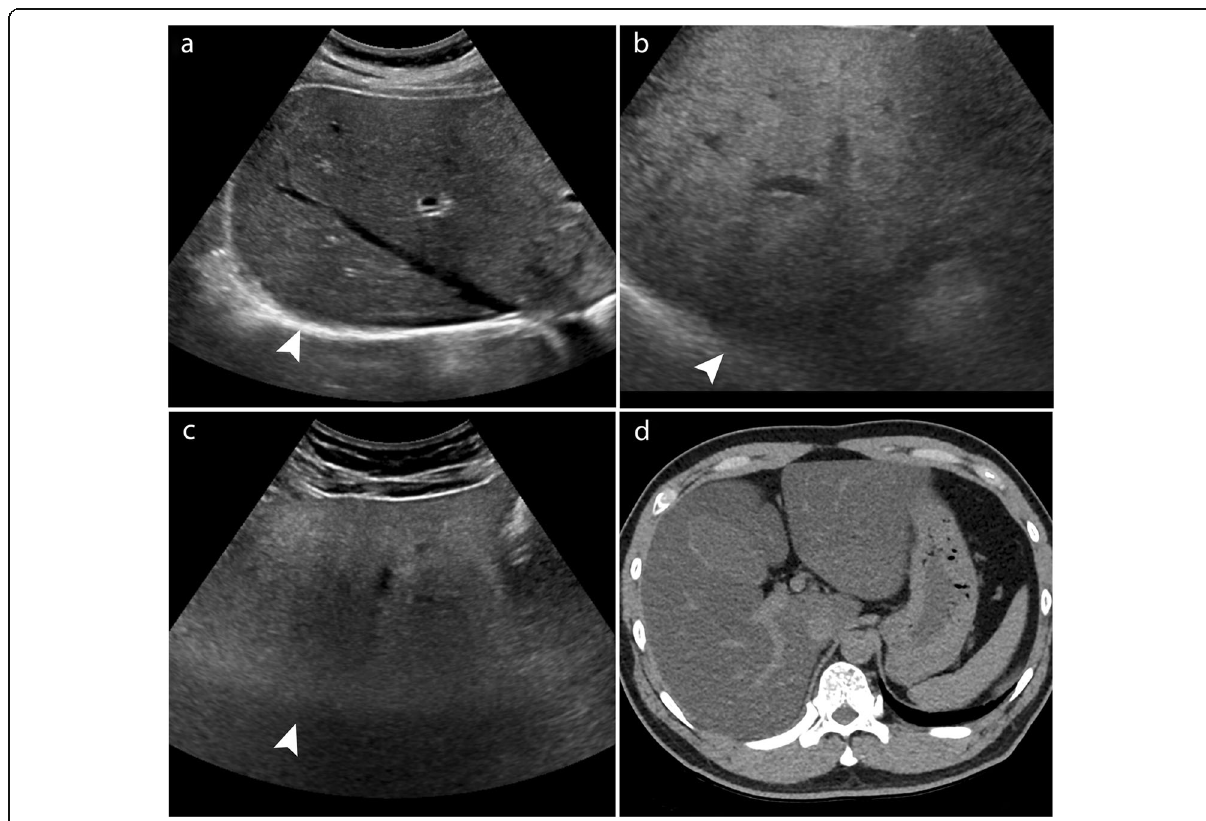
Fig. 1 Liver Imaging Reporting and Data System ultrasound visualisation scores. a Example of ultrasound visualisation score A: no or minimal limitations with complete visualisation of the diaphragm (arrowhead). b Example of ultrasound visualisation score B: moderate limitations. Shadowing and attenuation from heterogeneous liver parenchyma may obscure small masses and less than 50% visualisation of the liver (arrowhead). c Example of ultrasound visualisation score C: severe limitations. Marked attenuation in a patient with severe fatty liver leads to poor visualisation of the majority of the liver and diaphragm (arrowhead), with corresponding computed tomography image shown in ( d )